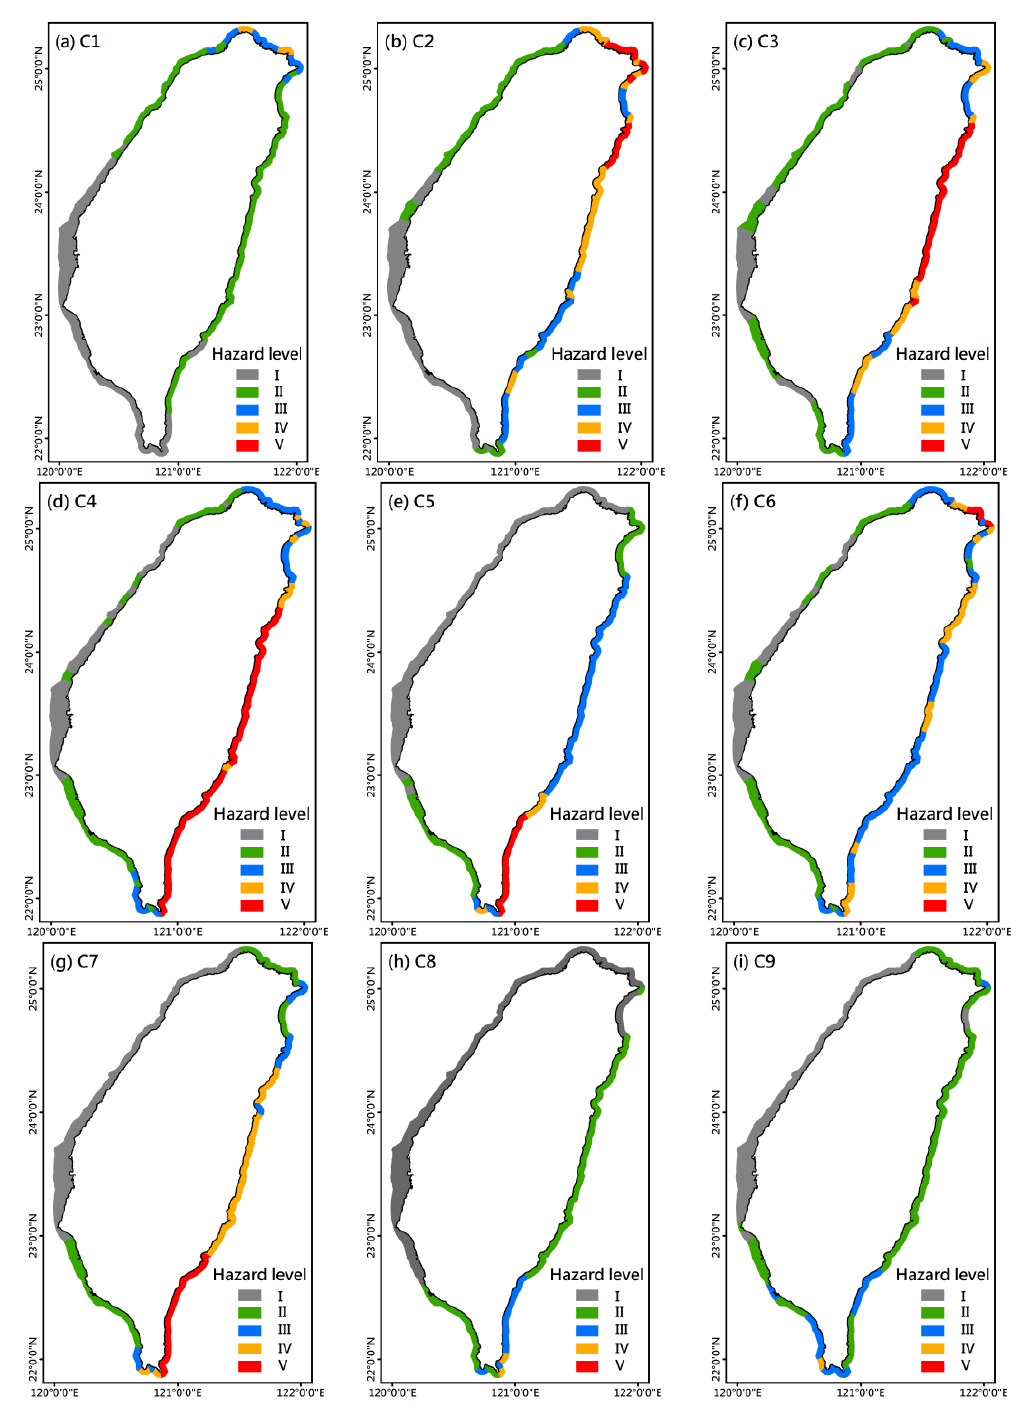
Figure 11. Storm wave hazard maps of C1 to C9 for the SACZ. ( a – i ) are corresponding to C1–C9.